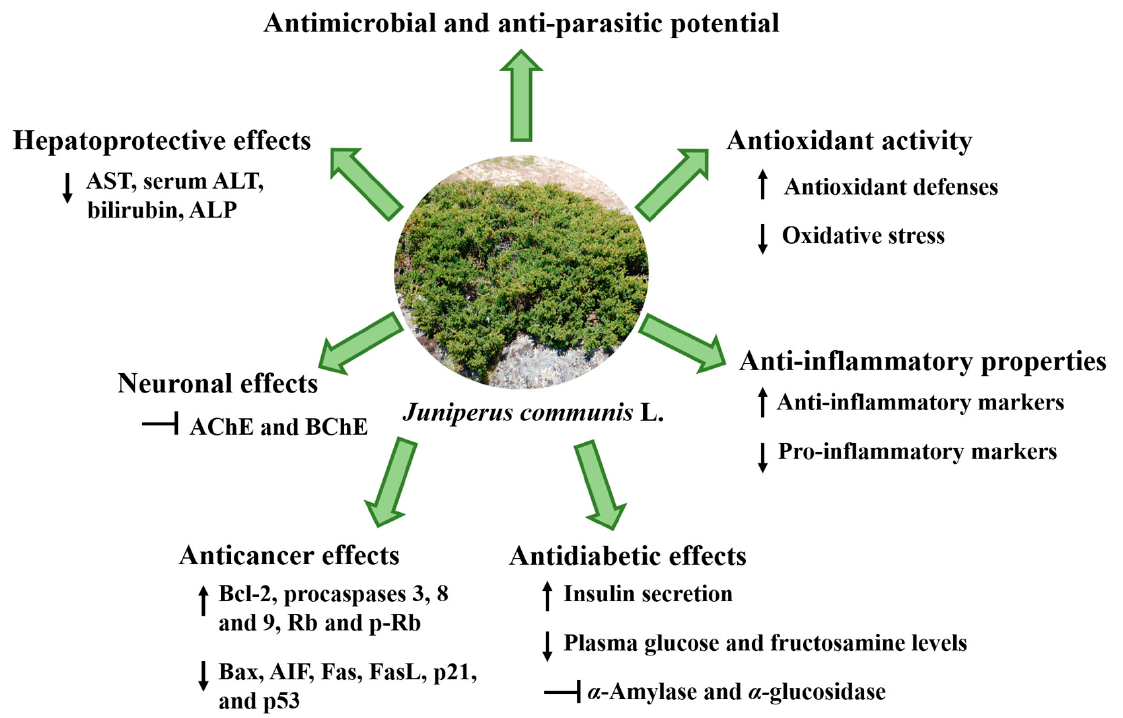
Figure 5. Main health-promoting properties attributed to Juniperus communis L. AST: aspartate amino- transferase; ALT: alanine aminotransferase; AChE: acetylcholinesterase; BChE): butyrylcholinesterase; Bax: Bcl-2-associated X protein; AIF: apoptosis-inducing factor; Fas: cell-surface death receptor; FasL: Fas ligand; Bcl-2: B-cell lymphoma 2; ↑ : increase; ↓ : reduction; T: